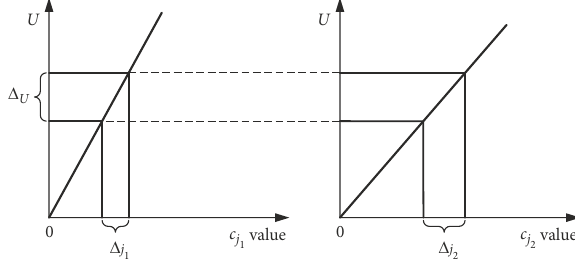
c and c 1 j 2 j